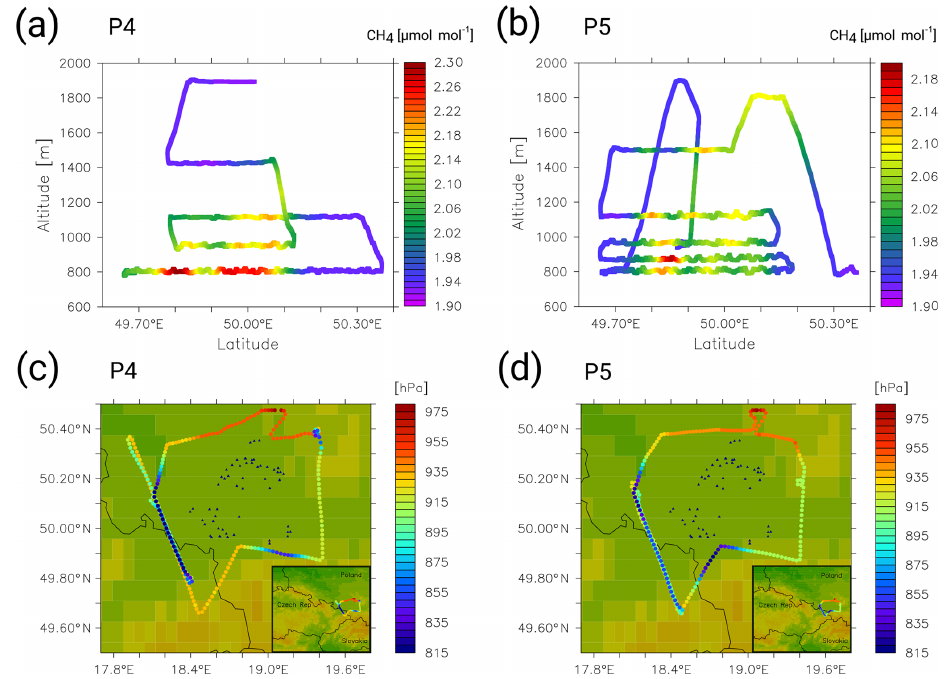
Figure 11. D-FDLR flight pattern in the USCB for P4 (a, c) and P5 (b, d) . Panels (a, b) show the vertical profile of the flight sections on 6 June 2018 between 10:10 and 11:20UTC (a) and between 13:25 and 15:10UTC (b) . The colour bars refer to the bias-corrected CH4_FX mixing ratios in micromoles per mole (µmolmol − 1 ) simulated by CM2.8. Panels (c, d) show the flight routes in the USCB for P4 (c) and P5 (d) . Here, the colour bars refer to the atmospheric pressure at flight level (hPa). Blue triangles show the locations of the coal mining ventilation shafts.